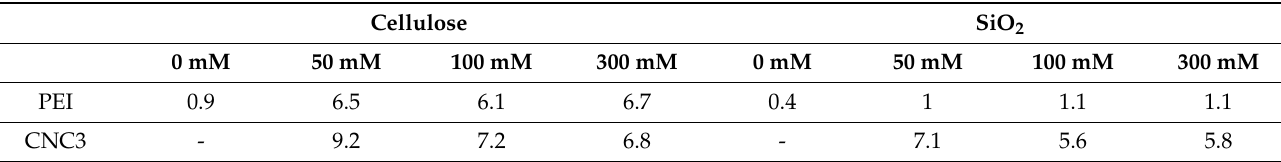
Figure 7. Layer thickness of the sequentially adsorbed PEI (at 50–300 mM NaCl) and CNCs on cellulose ( A , B ) and SiO 2 ( C , D ) surfaces. Table 1. Atomic force microscopy (AFM) root mean square (RMS) roughness values of the (first) polyethylenimine (PEI) in bilayer 1, and (final) CNCs coating in bilayer 3 created on cellulose and SiO 2 surfaces at different ionic strength of